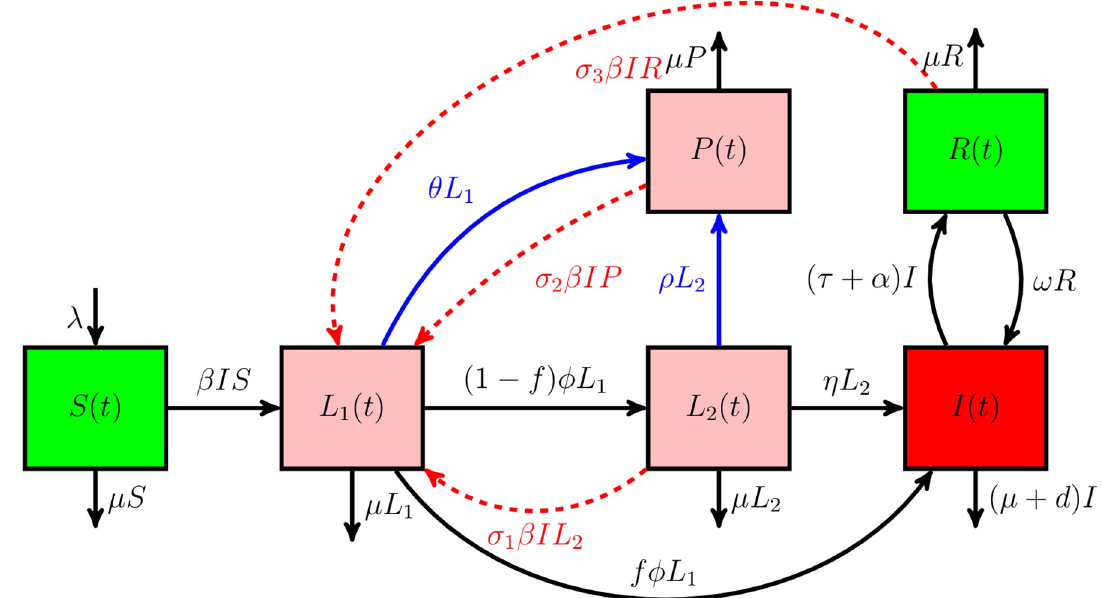
Fig 1. Schematic representation of the model. The square boxes represent classification of the general population into six mutually exclusive subpopulations, i.e., susceptibles S ( t ), early latents L 1 ( t ), late latents L 2 ( t ), individuals treated with isoniazid preventive therapy P ( t ), individuals with active TB I ( t ), and recovered individuals R ( t ). All arrows indicate either inflow or outflow or transition between compartments. Blue arrows illustrate transition of latently infected individuals as a result of treatment with IPT. Red dashed arrows show reinfection of late latently infected individuals, individuals treated with IPT and recovered individuals, respectively represented by σ i , i = 1, 2,